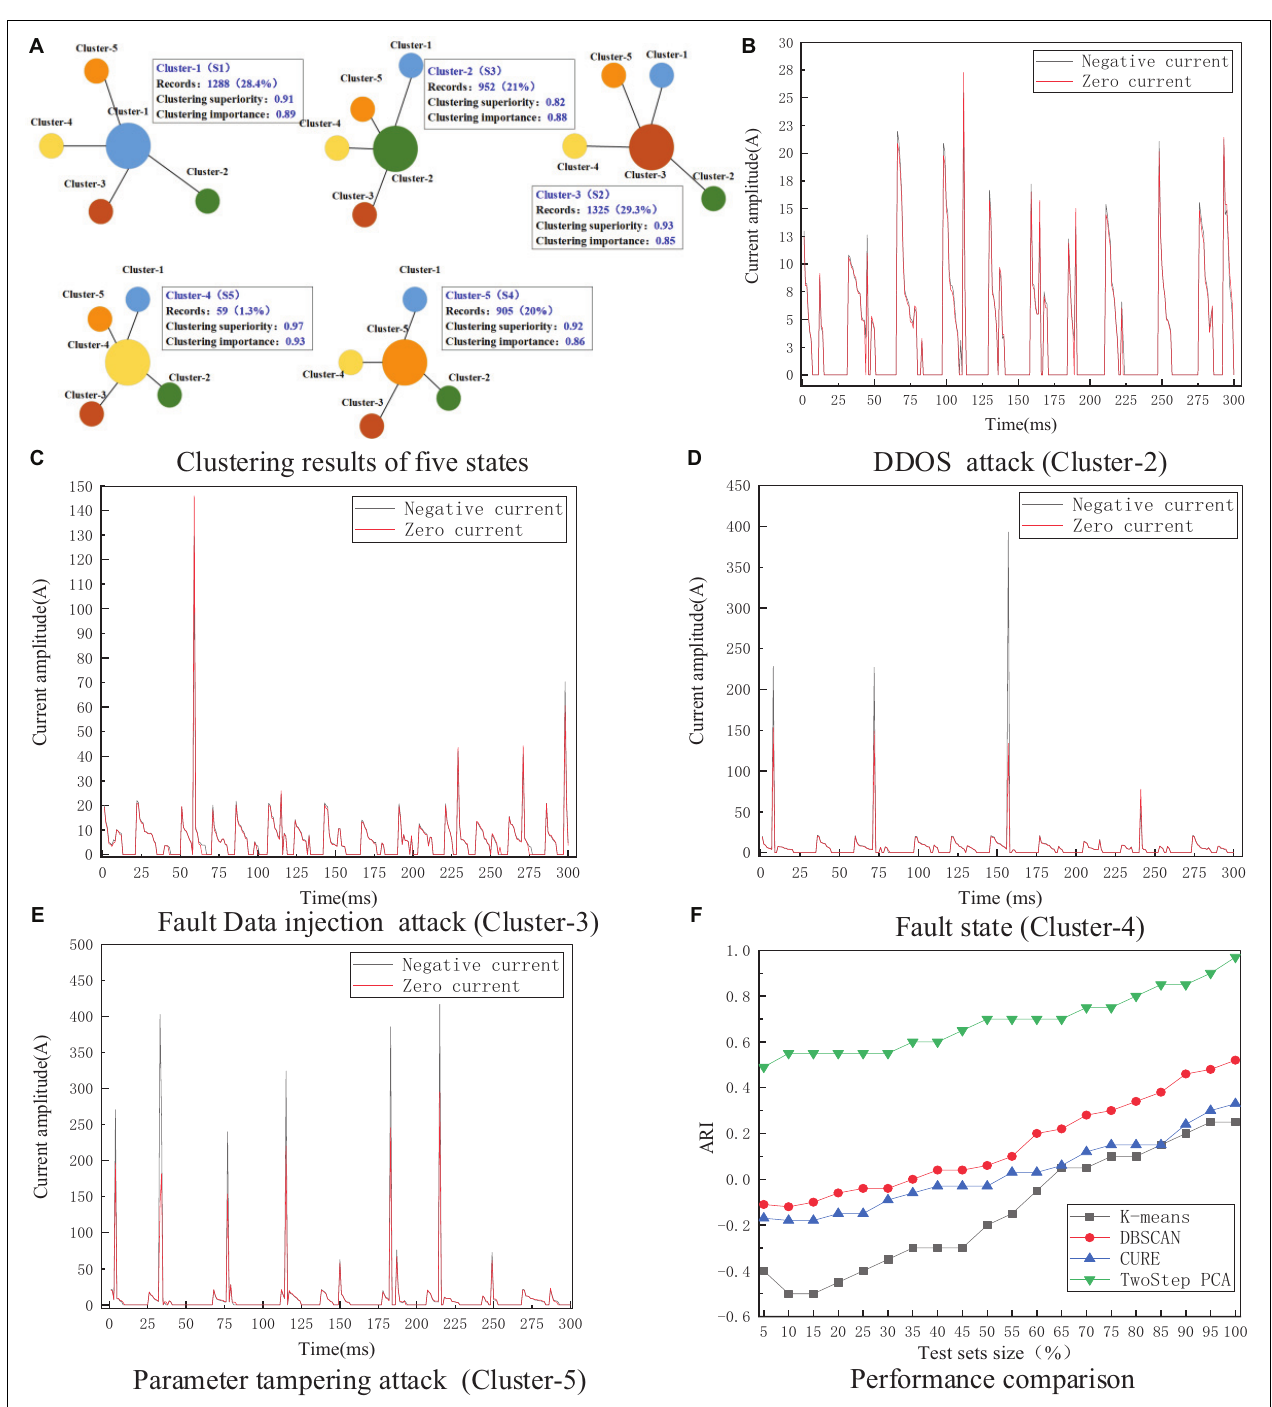
FIGURE 2 | Clustering results of five states (A) , Current amplitude under DDOS attack (B) , Current amplitude under fault data injection attack (C) , Current amplitude under fault state (D) , Current amplitude under parameter tampering attack (E) , Performance comparison (F) .